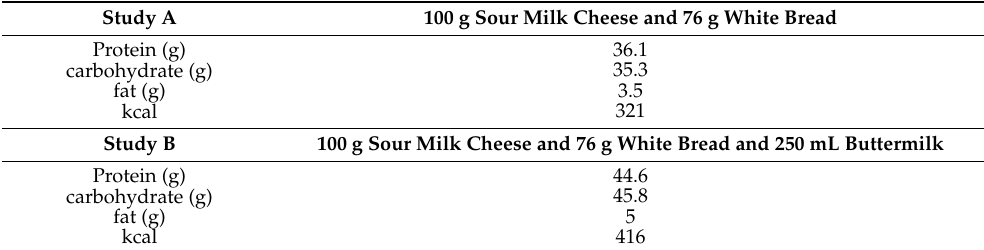
Table 1. Nutritional values in Studies A and